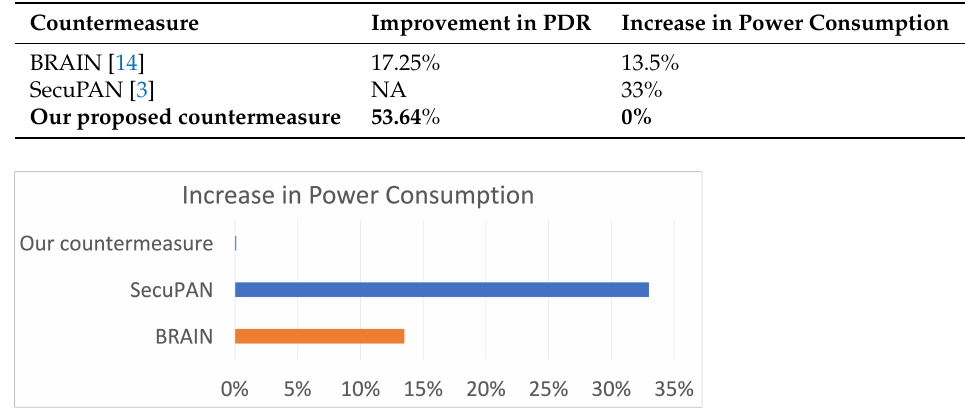
Table 6. Comparison with other countermeasures.